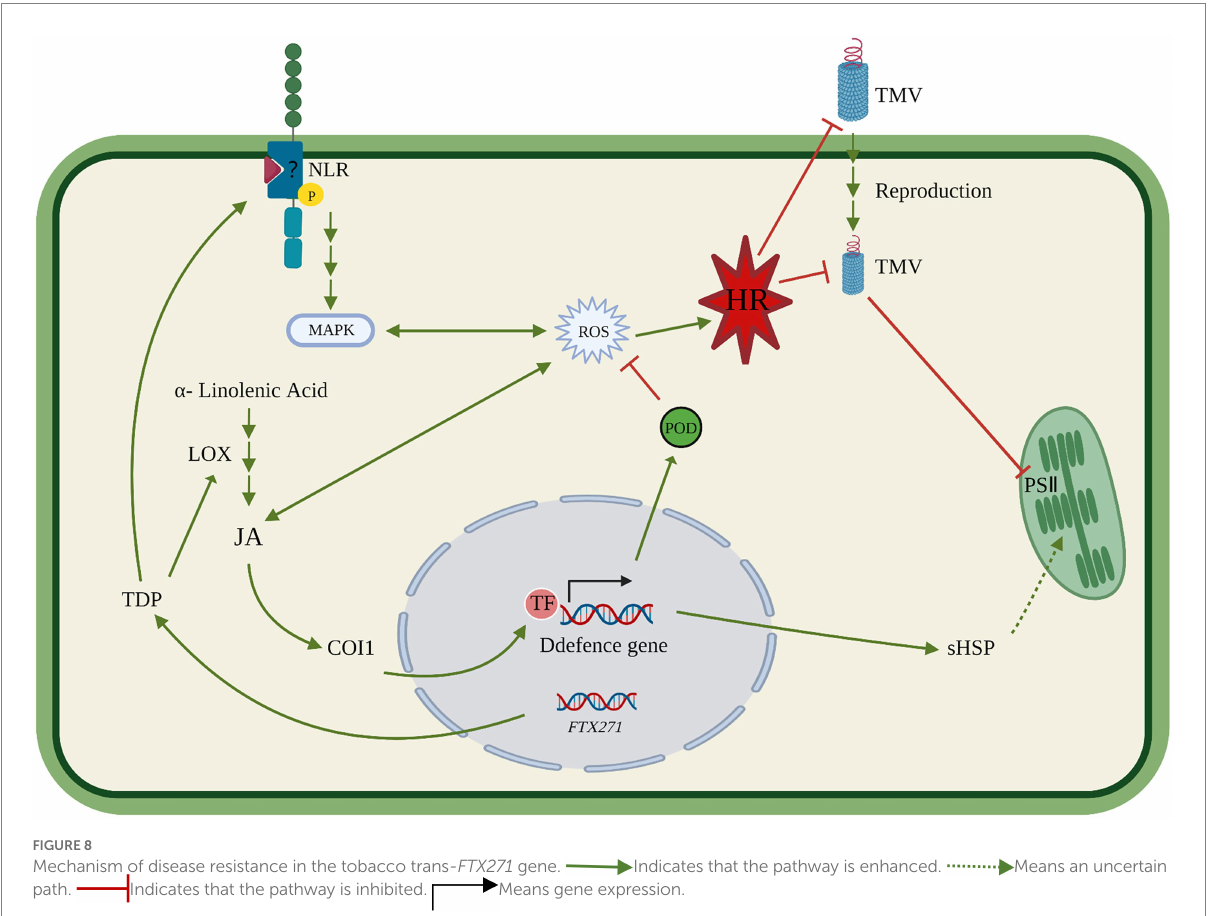
FIGURE 8 Mechanism of disease resistance in the tobacco trans- FTX271 gene. Indicates that the pathway is enhanced. Means an uncertain path. Indicates that the pathway is inhibited. Means gene